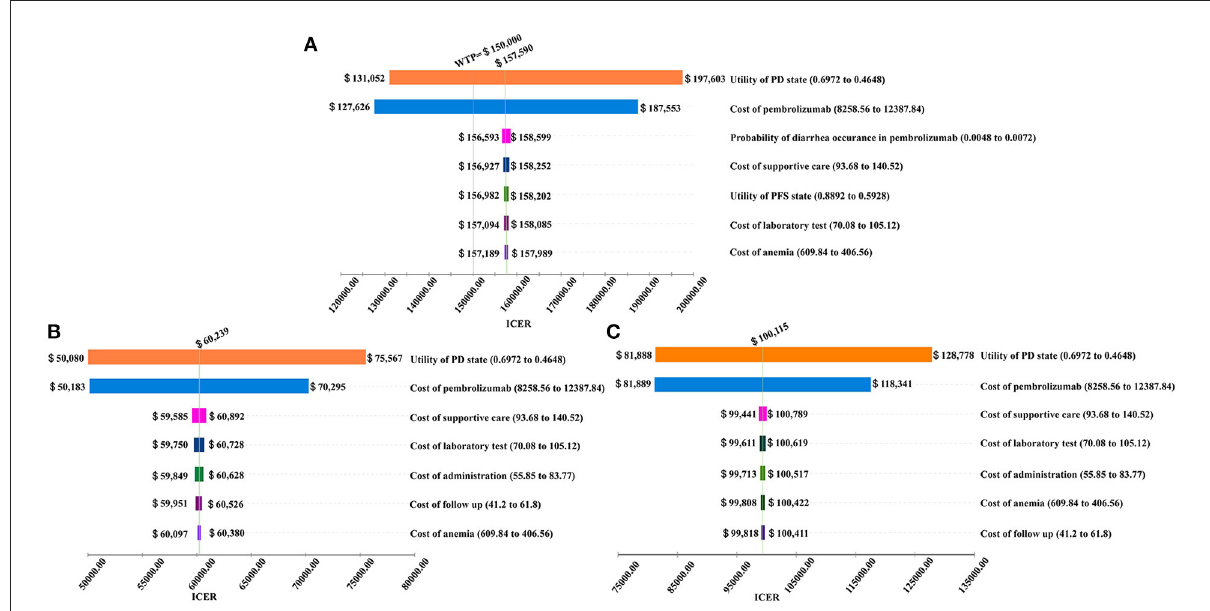
FIGURE2 Tornado diagram for the ICER per QALY of pembrolizumab vs. chemotherapy in three groups (A) the Intent-to-treat Population; (B) Patients with Squamous Cell Carcinoma; (C) Patients with programmed cell death-Ligand 1 (PD-L1) combined positive score (CPS) ≥